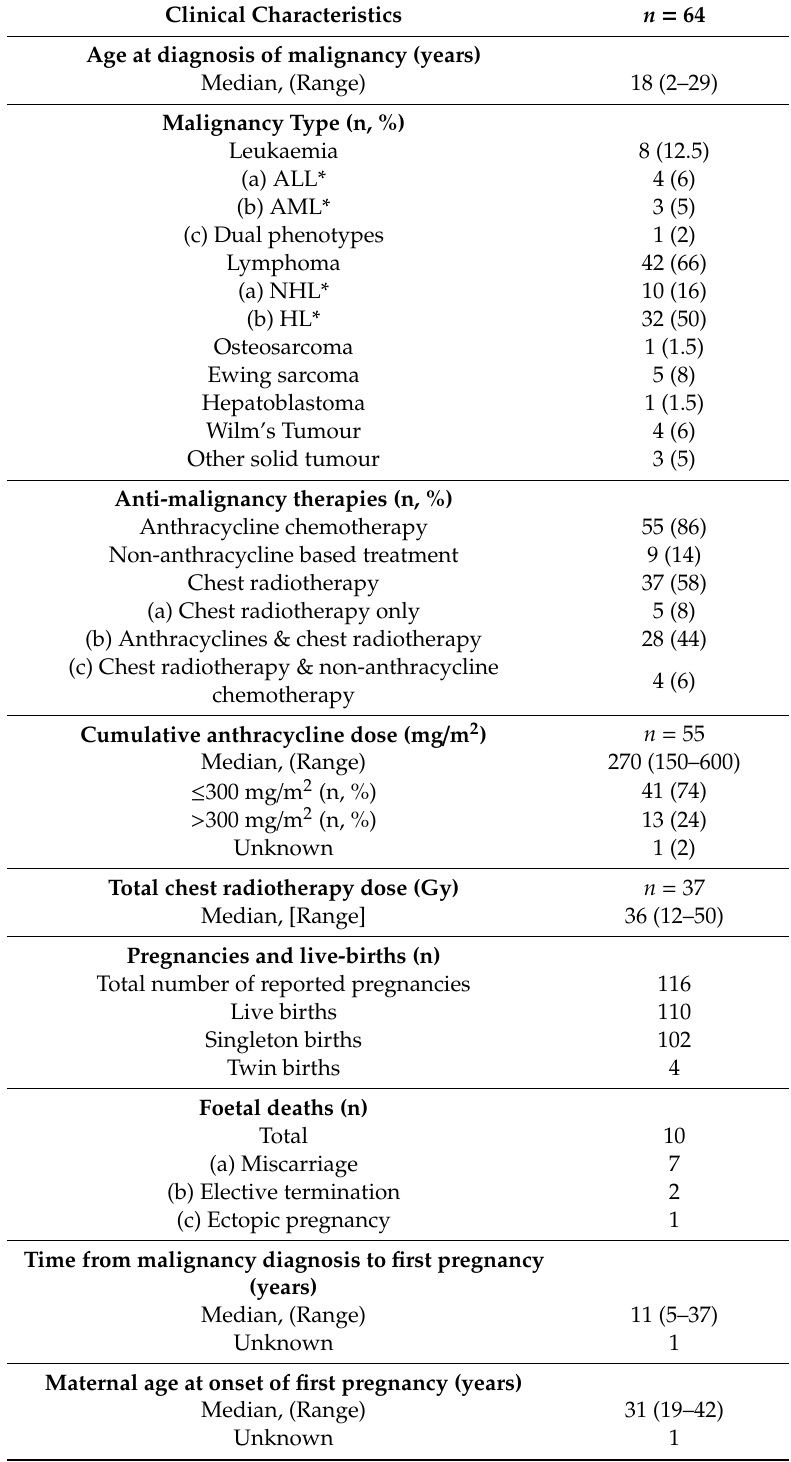
Table 1. Patient characteristics of 64 long-term survivors with subsequent